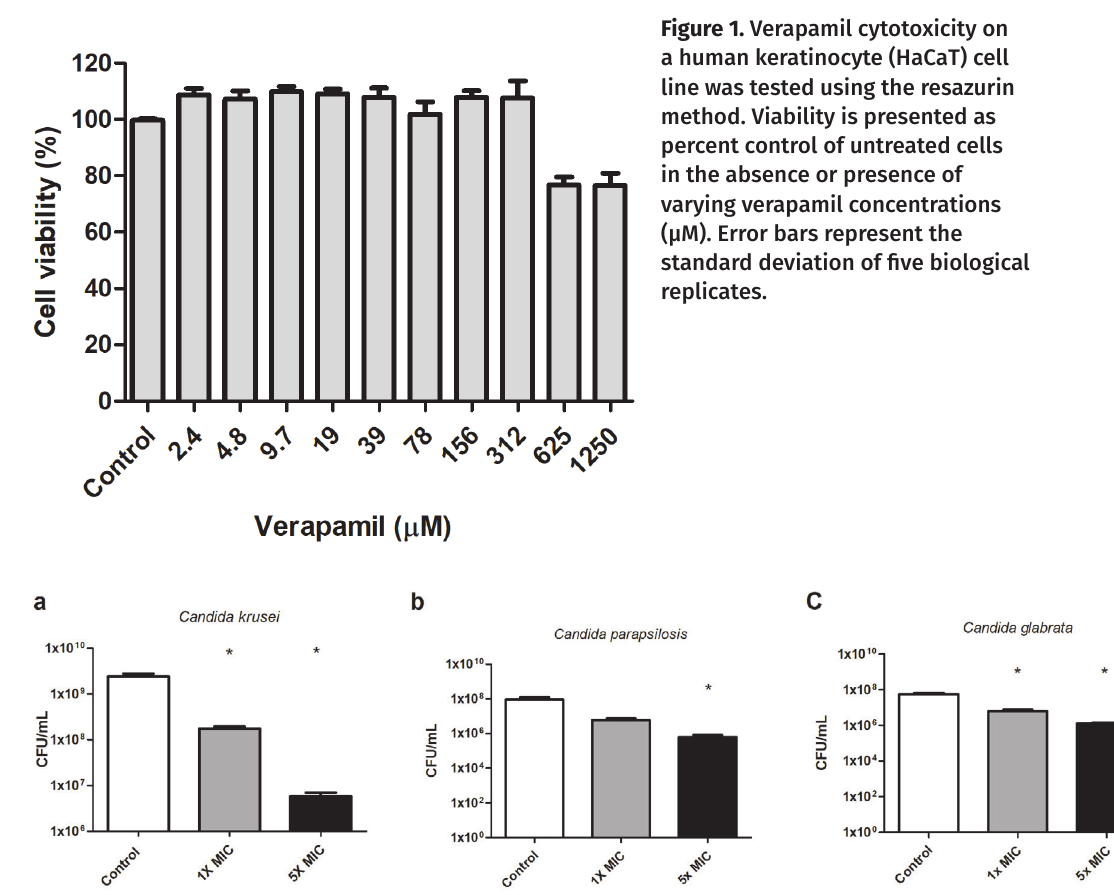
Figure 2. Biofilm viability of non- albicans Candida species after treatment with verapamil at the MIC and five times the MIC. (a) C. krusei ; (b) C. parapsilosis ; (c) C. glabrata. Asterisks represent statistically significant differences with untreated biofilm (control) as shown by ANOVA (p < 0.05). Error bars represent the SEM (standard error of the mean) of eight biological